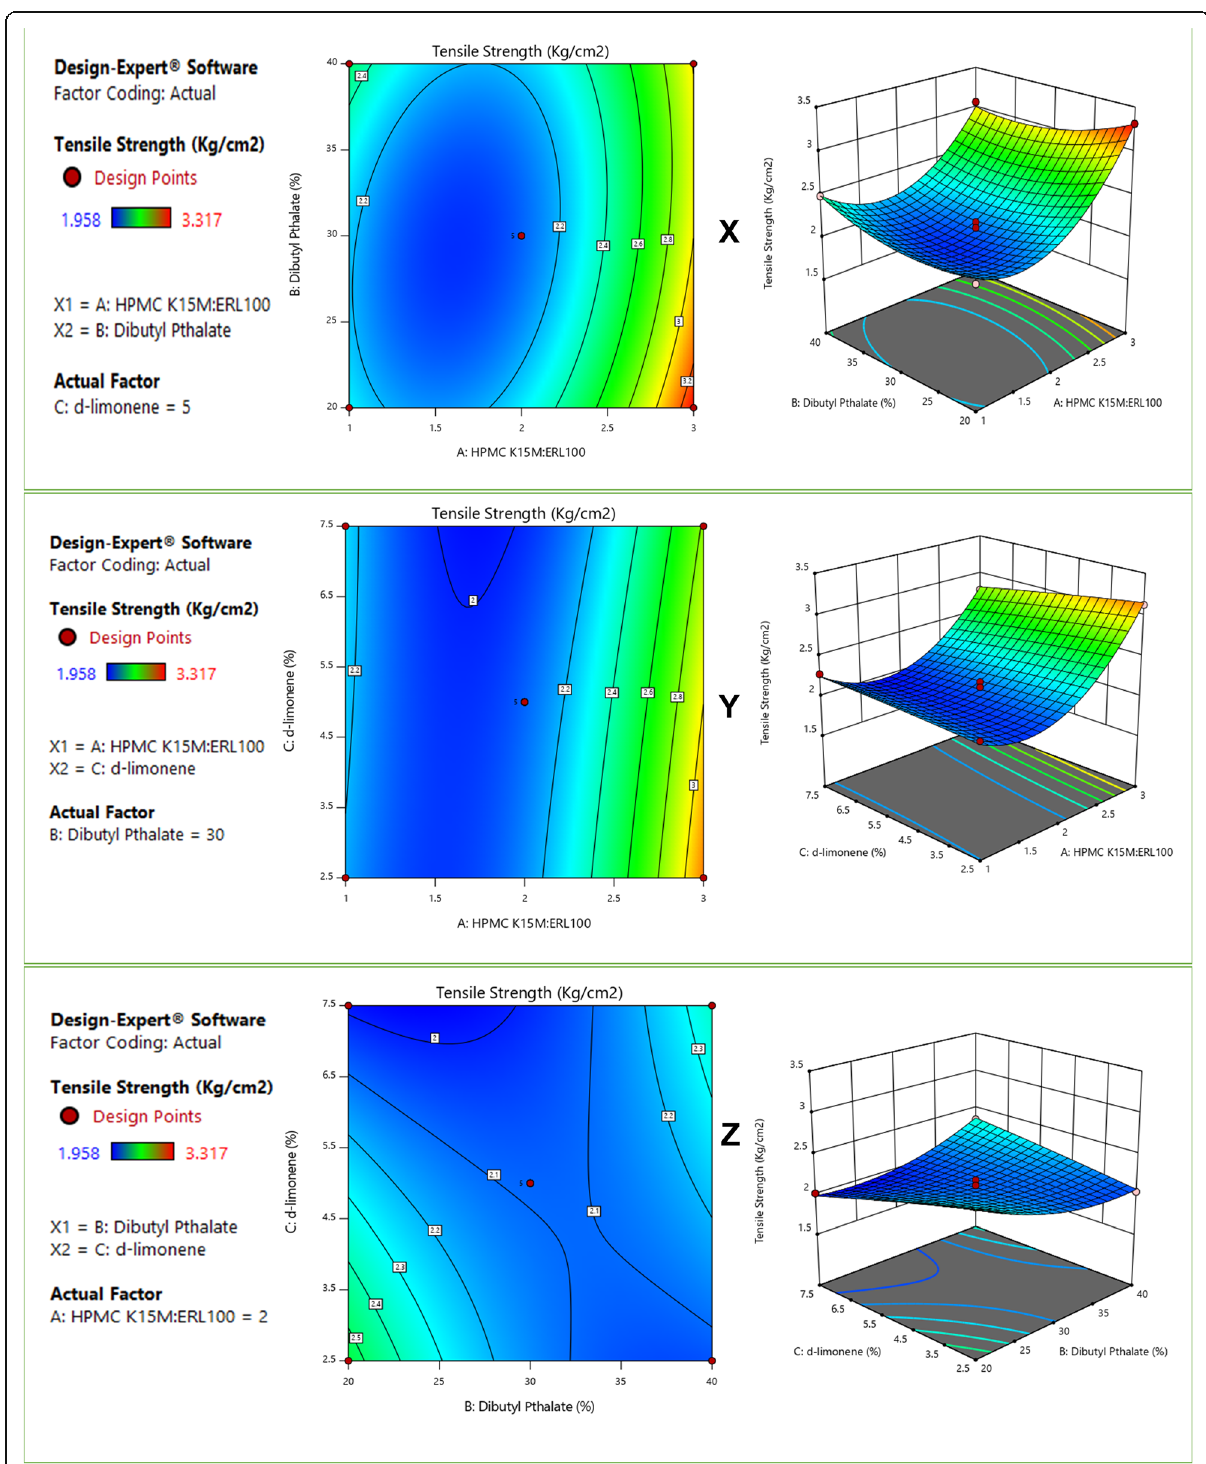
Fig. 3 Response surface plot showing effect of X polymer (HPMC K15M:ERL100) ratio ( a ) and di-butyl phthalate (% w/w) ( b ); Y polymer (HPMC K15M:ERL100) ratio ( a ) and concentration of d-limonene (% w/w) ( c ); Z di-butyl phthalate (% w/w) ( b ) and concentration of d-limonene (% w/w) ( c ) on response R 1 (tensile